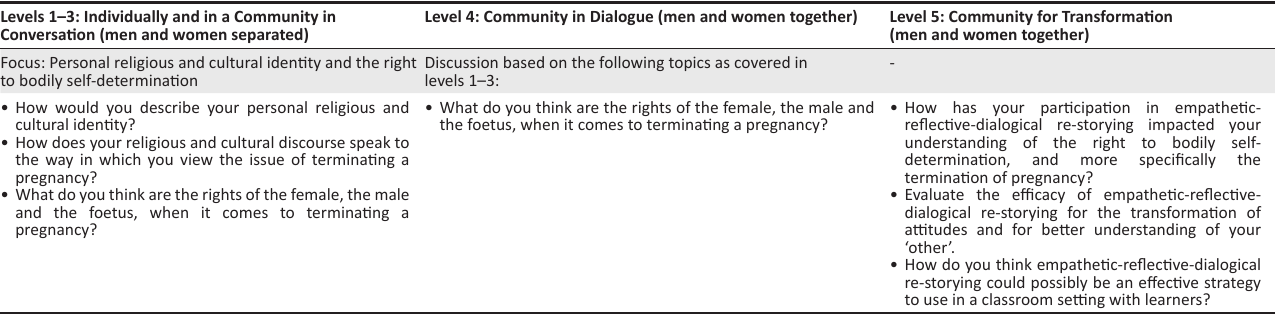
TABLE 2: Questions informing the focus on religious identity and the right to bodily self-determination.